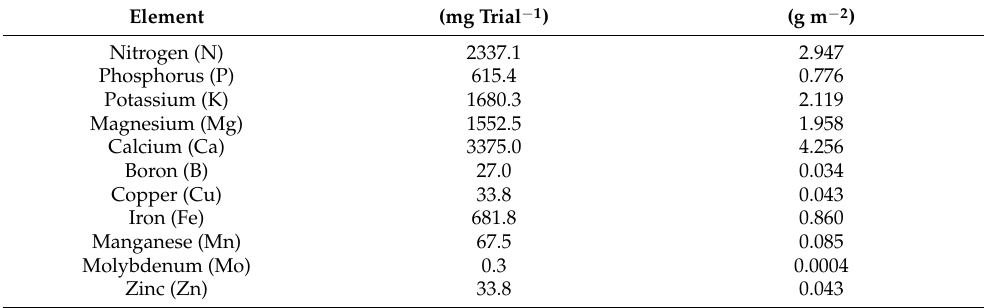
Table 4. SOF inputs: Overview of types, amounts and dosages of nutrients applied in this study [28].